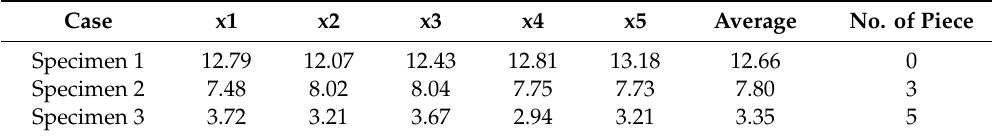
Table 2. Experimental results of maximum displacements in x-direction [mm].